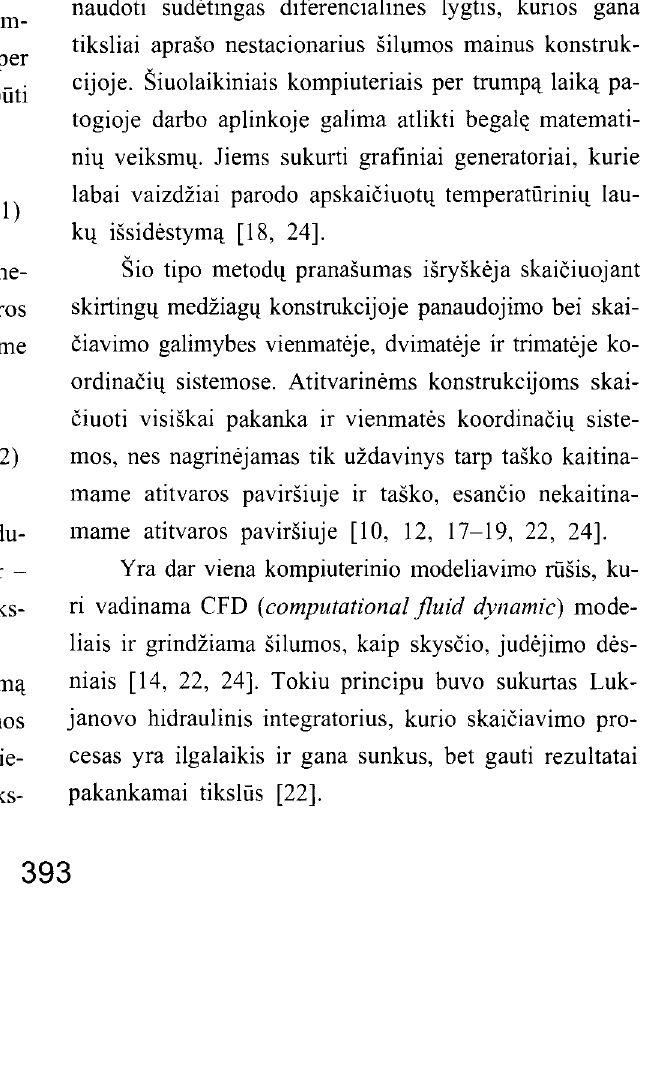
Fig 2. "Fictitious layer" method principle Siuo atveju vyksta temperatilros laidumo procesas medziagoje (2 pav.). Juo metu dalis silumos srauto